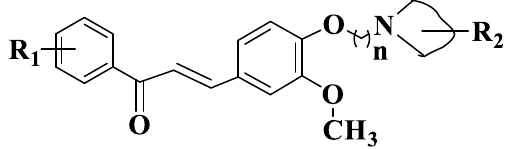
Figure 11. General structure of quinoline chalcones (compounds 190 – 214 ).